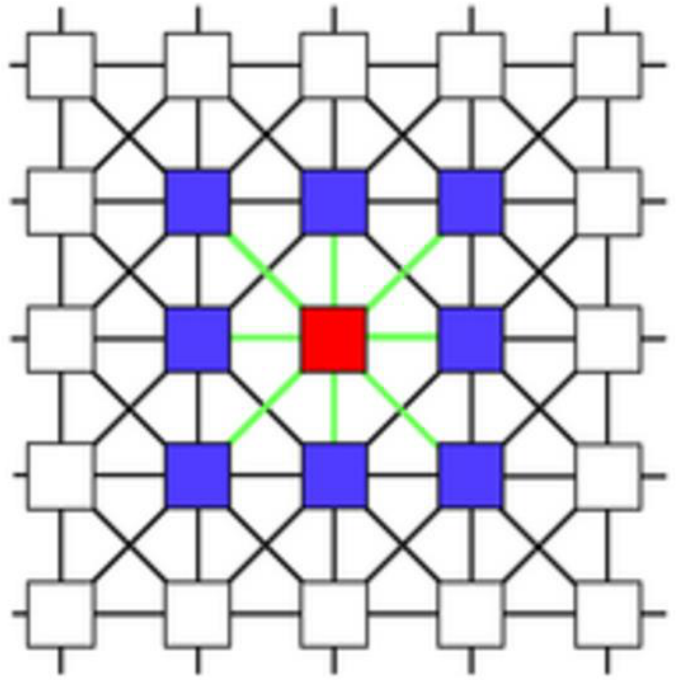
Figure 4. Illustration of the CNN coupling structure.